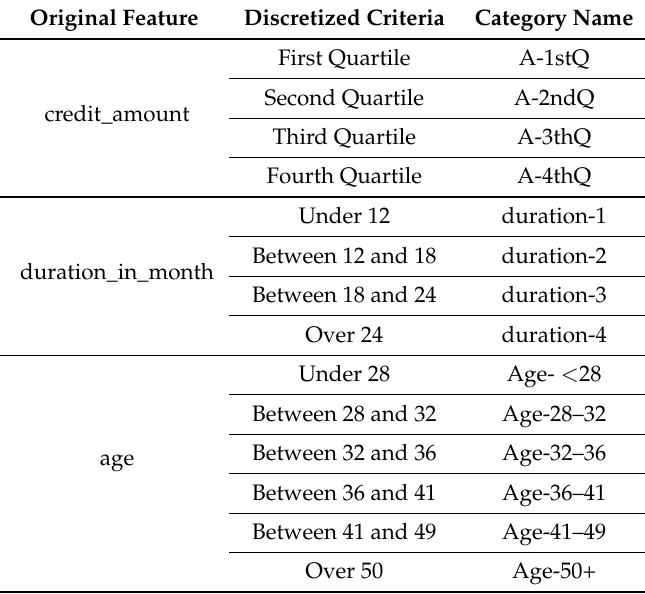
Table 4. Discretized criteria for the German Credit